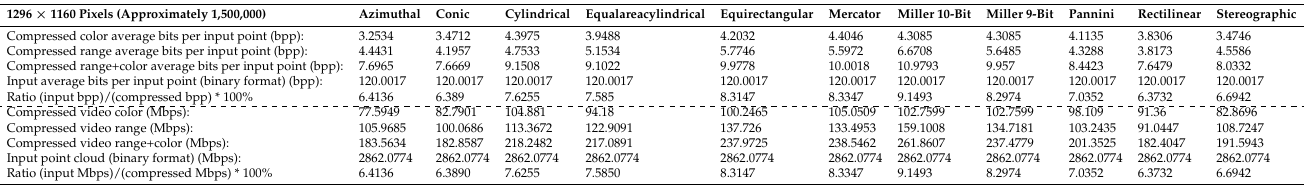
Table 2. Information about the compressed file sizes for different projection types, with projection area of 1296 × 1160 pixels (approximately